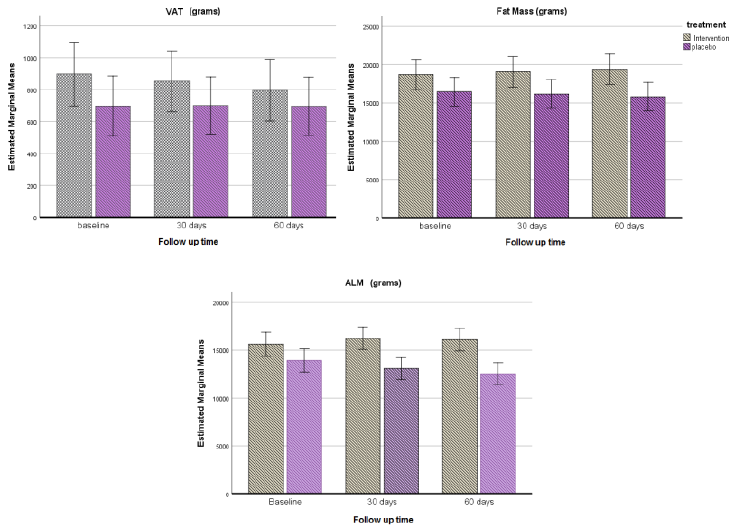
Figure 3. Body composition changes after 30 and 60 days of treatment. Weight, FM, and ALM were measured after 30 days from the start of the treatment; no significant differences between OLEP and placebo group were reported in the ob- served variables. These variables showed statistically significant trend changes at the end of the treatment period. Figure 4 depicts the amino acids profile mean difference changes from baseline to 60 days. Amino acids profile represented by valine, leucine, isoleucine, and total amino acids showed a statistically significant increase in the intervention group in comparison to the placebo group at 60 days ( p = 0.001).